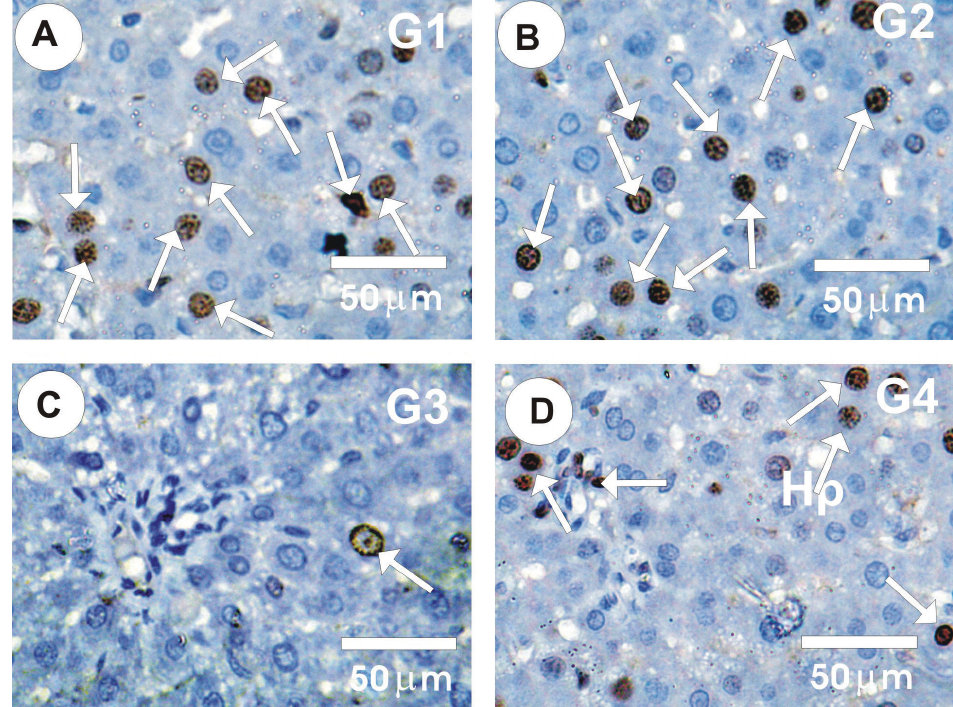
FIGURE 2 - Photomicrographs of liver sections stained with KI67-ir in the different groups; (A&B) Liver section in control and GSPE groups showed strong positive reaction (arrows) for Ki67-ir (grade 4) in hepatocyte nuclei; (C) Liver sections in Gleevec rats group showed mild to faint positive reactions for Ki67-ir; (D) Liver sections in treated Gleevec with GSPE showed moderate positive reactions (arrows) for